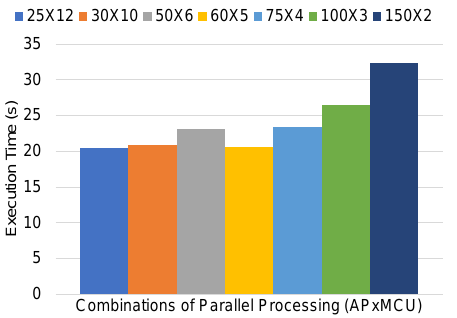
Figure 8. Data verification time comparison between combinations of parallel processing